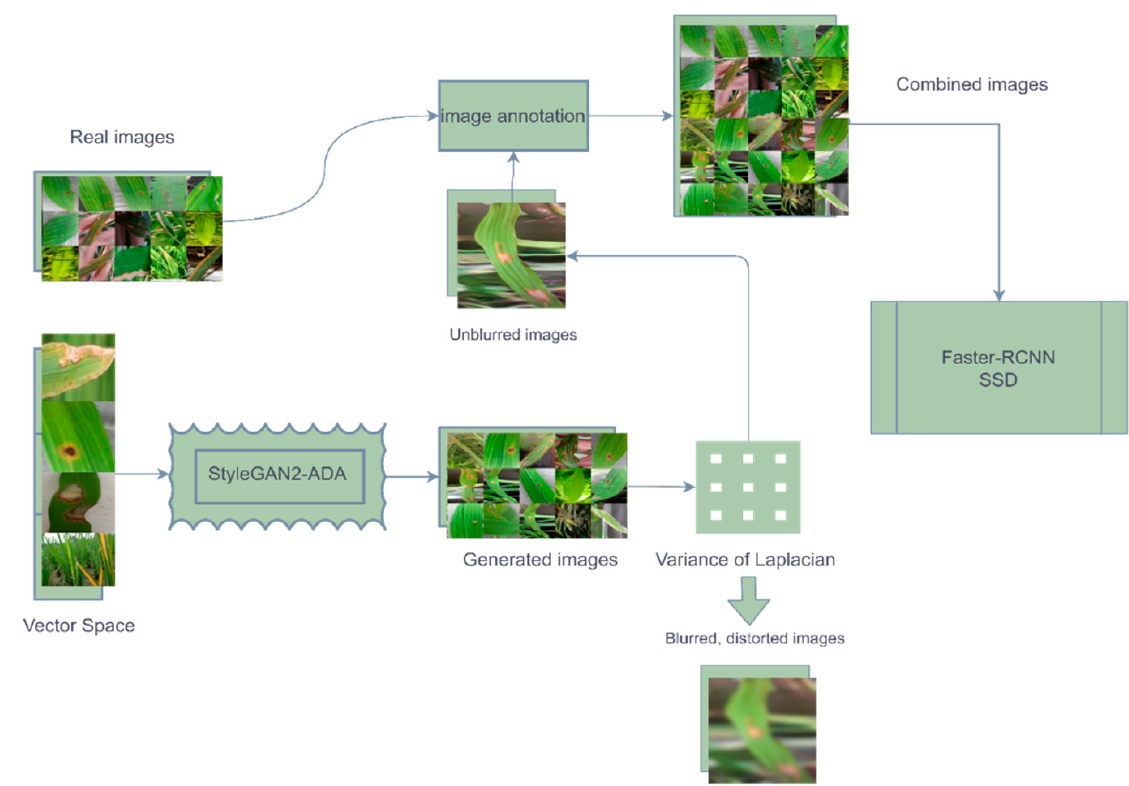
Figure 3. Visual illustration of the proposed GAN-based augmentation pipeline.